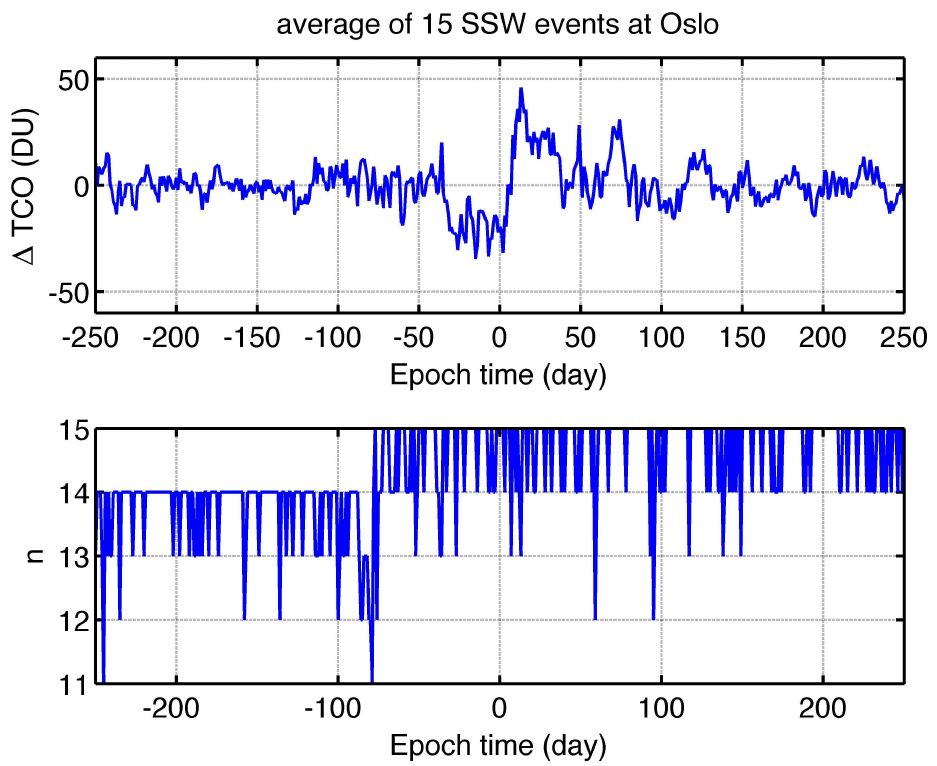
Figure 5. Composite of 15 major SSWs at Oslo (GBcomb data). The lower panel shows the number of measurements which were averaged in the composite shown in the upper